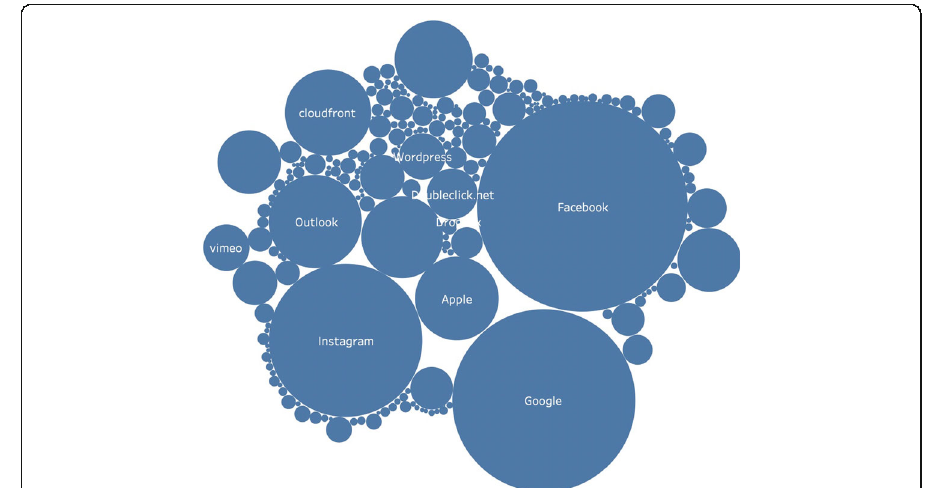
Fig. 3 General use of applications in Aesthetics classe